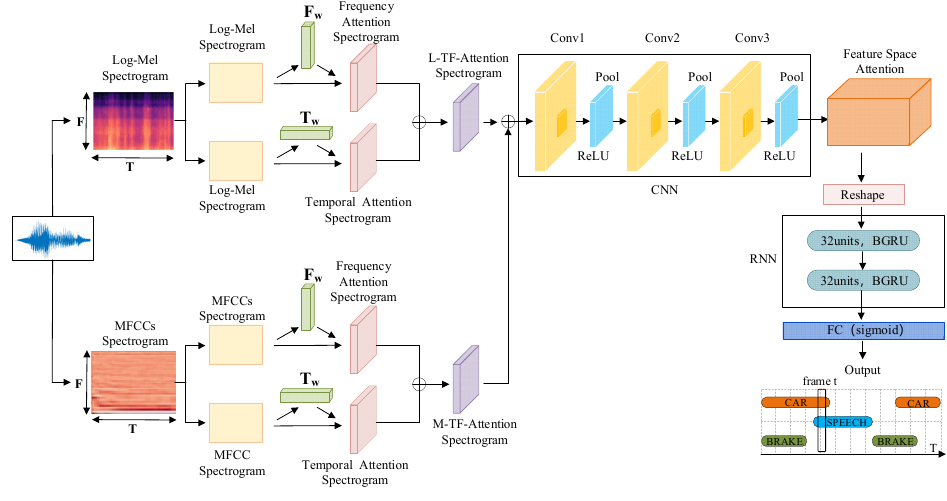
Figure 1. TFFS-CRNN network structure